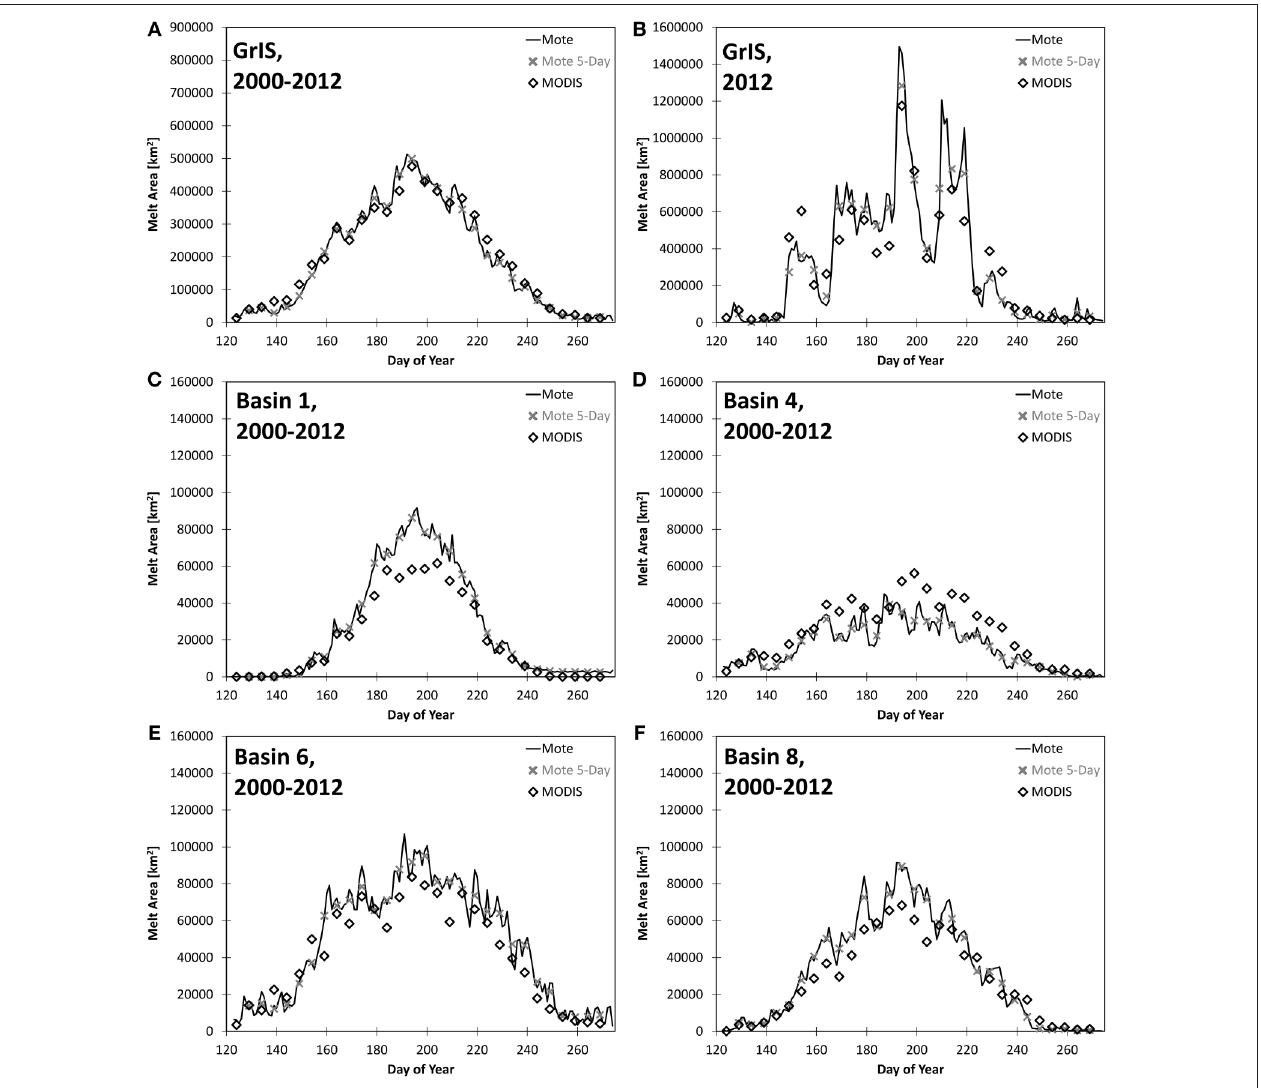
FIGURE 4 | Annual time series of melt area derived from passive microwave (solid line) and MODIS 5-day averages (diamonds), in km 2 . Passive microwave 5-day averages corresponding to the MODIS values are indicated with an “ × .” Time series are indicated for (A) the total GrIS, averaged for 2000-2012; (B) the total GrIS for the year 2012; and (C) drainage basin 1, (D) basin 4, (E) basin 6, and (F) basin 8 averaged for